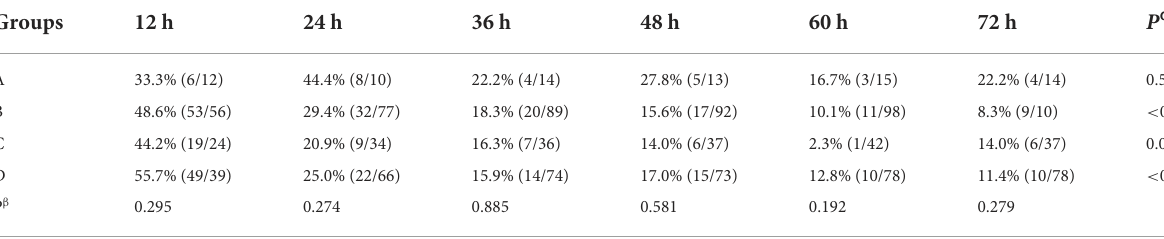
TABLE 4 The frequency of rescue medication at 12, 24, 36, 48, 60, and 72h after treatment. Groups